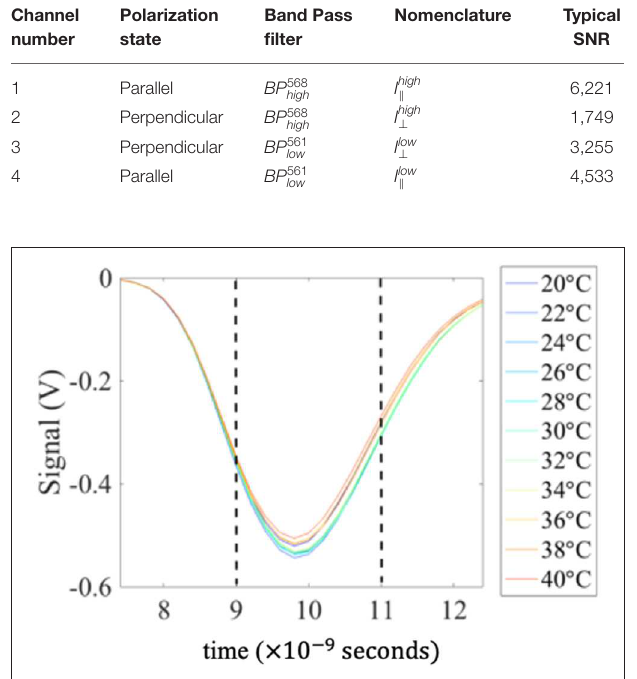
FIGURE 4 | A typical set of signals (channel 4), recorded for different temperatures and showing the area over which the signals were integrated.